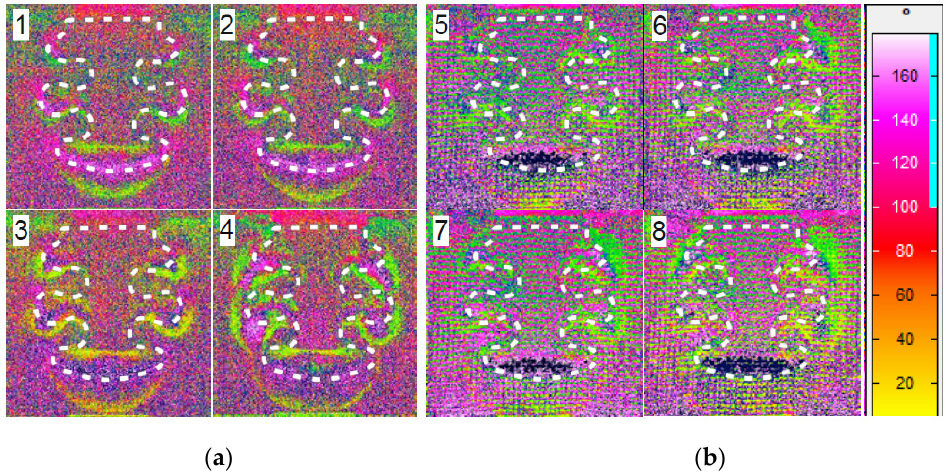
Figure 13. Phase images of the hybrid specimens in dynamical testing @ 23 °C ( 1 – 4 ) and 60 °C ( 5 – 8 ); ( a ) @ 10 4 , 3 × 10 4 , 6 × 10 4 , 10 5 cycles; ( b ) @ 10 4 , 2 × 10 4 , 3 × 10 4 , 4 × 10 4 cycles.